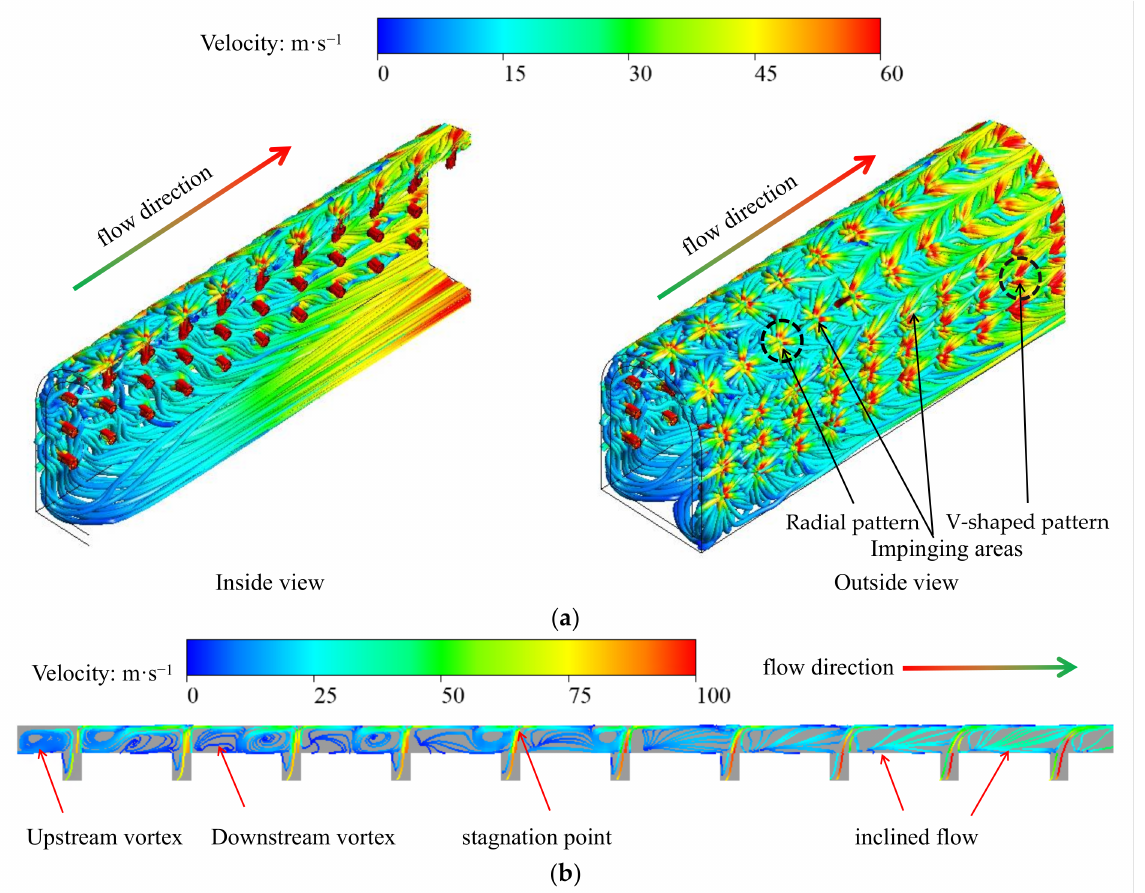
Figure 5. Flow field distribution characteristics of steam jet array impingement cooling in the quasi-leading-edge channel: ( a ) three-dimensional flow field; ( b ) two-dimensional flow field on the mid-section of the